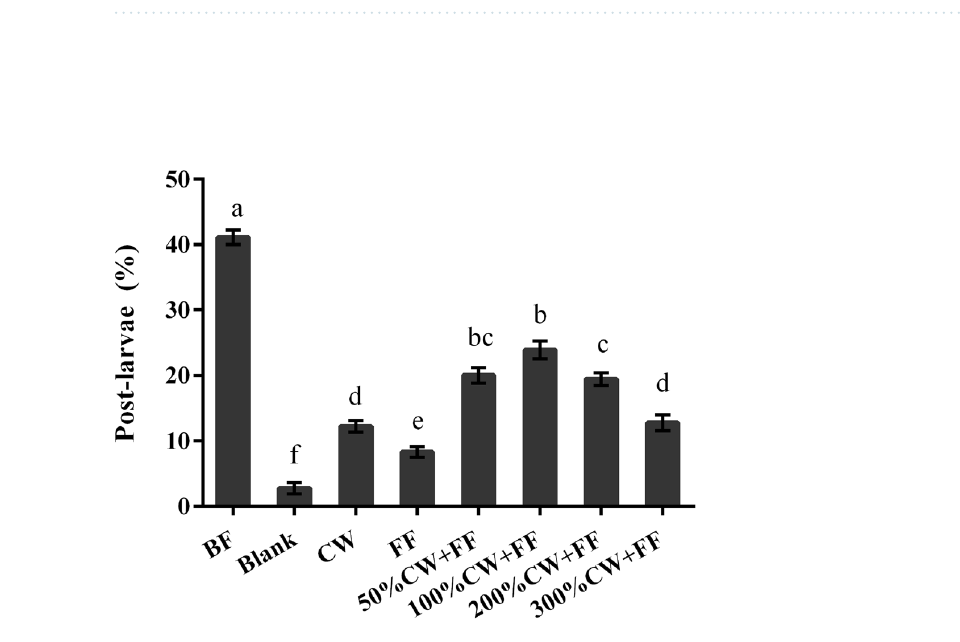
Figure 6. Post-larvae rate in CW and FF Virgibacillus sp. 1 BFs. Small letter suggests significant variance ( p < 0.05). Means ± SE (n =